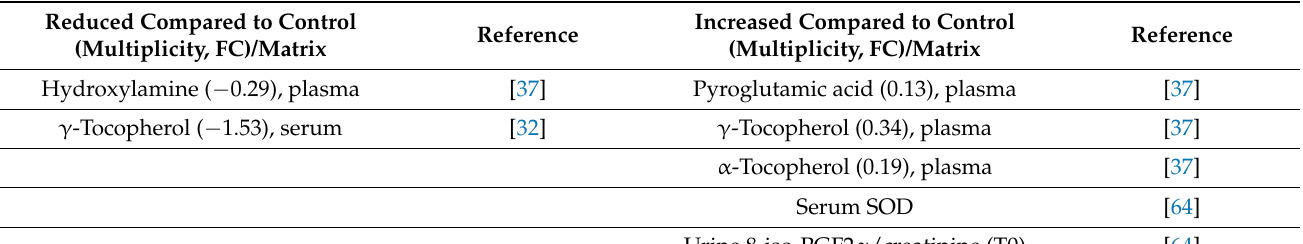
Table 6. Oxidative stress biomarkers of